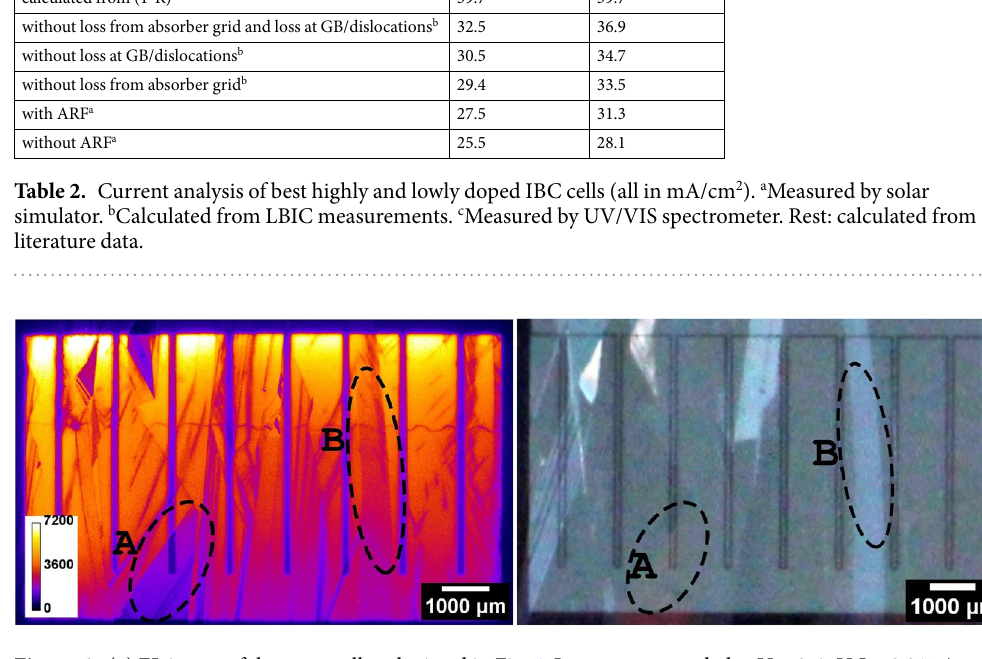
Figure 6. ( a ) EL image of the same cell as depicted in Fig. 4. Image was recorded at V = 0.67 V, I = 0.015 A. Counts in arbitrary intensity units. Same measurement artefact from a glass irregularity as in Fig. 4 is seen as wobbly line perpendicular to the grid fingers. Local intensity variations stem from contact resistance or lifetime variations. Optical microscope image of the back side of the same cell. Image was mirrored to directly compare electro-optical effects ( a ) with pure optical effects ( b ). Dashed ellipses mark areas used for evaluating optical, series resistance and lifetime effects together with areas in Fig.